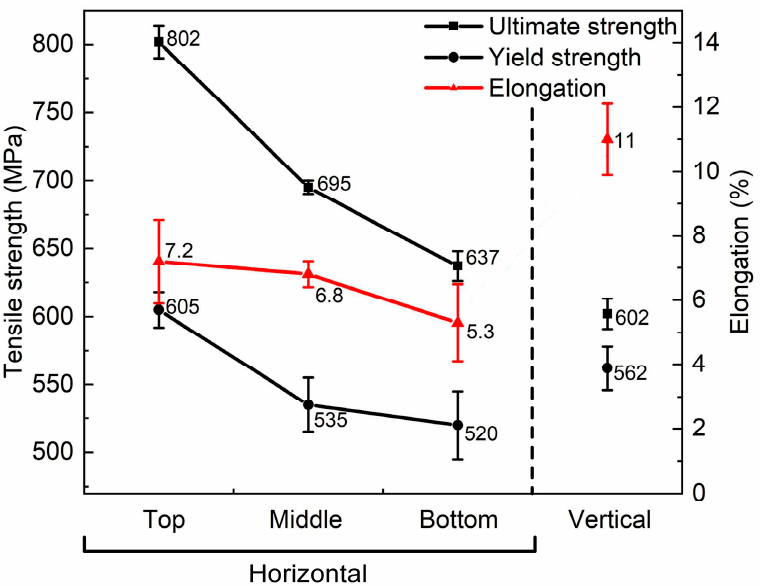
Figure 9. The measured yield strength, ultimate strength, and elongation.